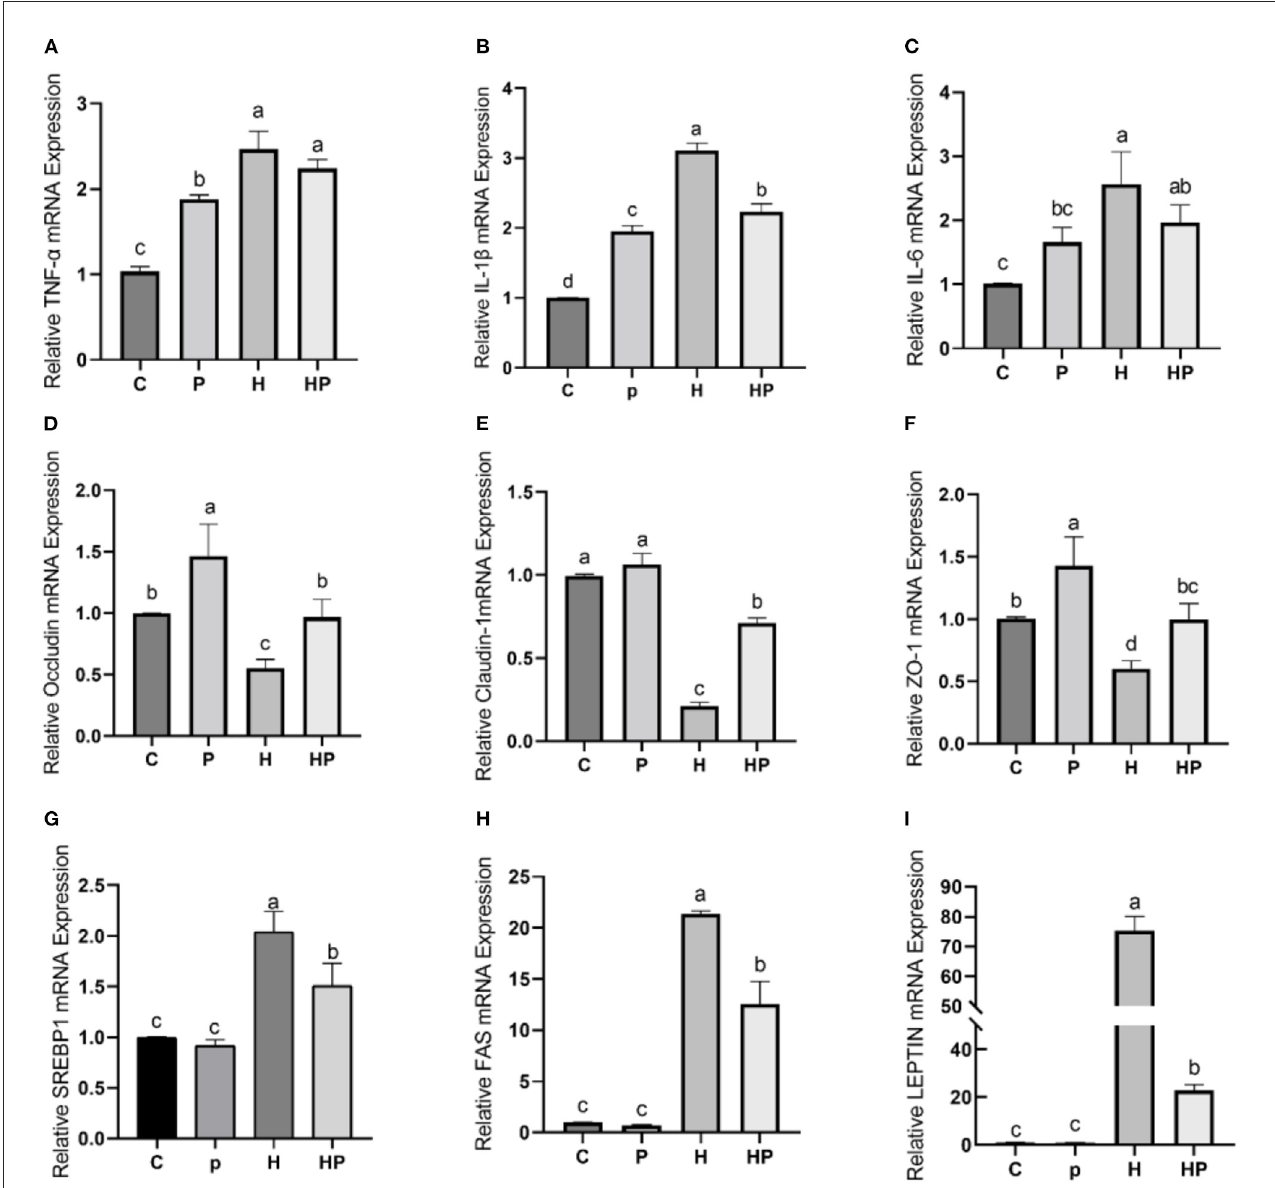
FIGURE7 Effect of P. pentosaceus PR-1 on intestinal inflammation, gut permeability, and lipid metabolism in HFD-fed zebrafish. (A–C) The total RNA was extracted from the intestine, and the relative mRNA expression levels of TNF- α (A) , IL-1ß (B) , and IL-6 (C) were determined by qRT-PCR. (D–F) The total RNA was extracted from the intestine, and the relative mRNA expression levels of Occludin (D) , Claudin-1 (E) , and ZO-1 (F) were determined by qRT-PCR. (G, H) The total RNA was extracted from the liver, and the relative mRNA expression levels of SREBP1 (G) , FAS (H) , and LEPTIN (I) were determined by qRT-PCR. Values were represented as the mean ± S.D. ( n = 6). Values with different superscript letters are significantly different ( p <